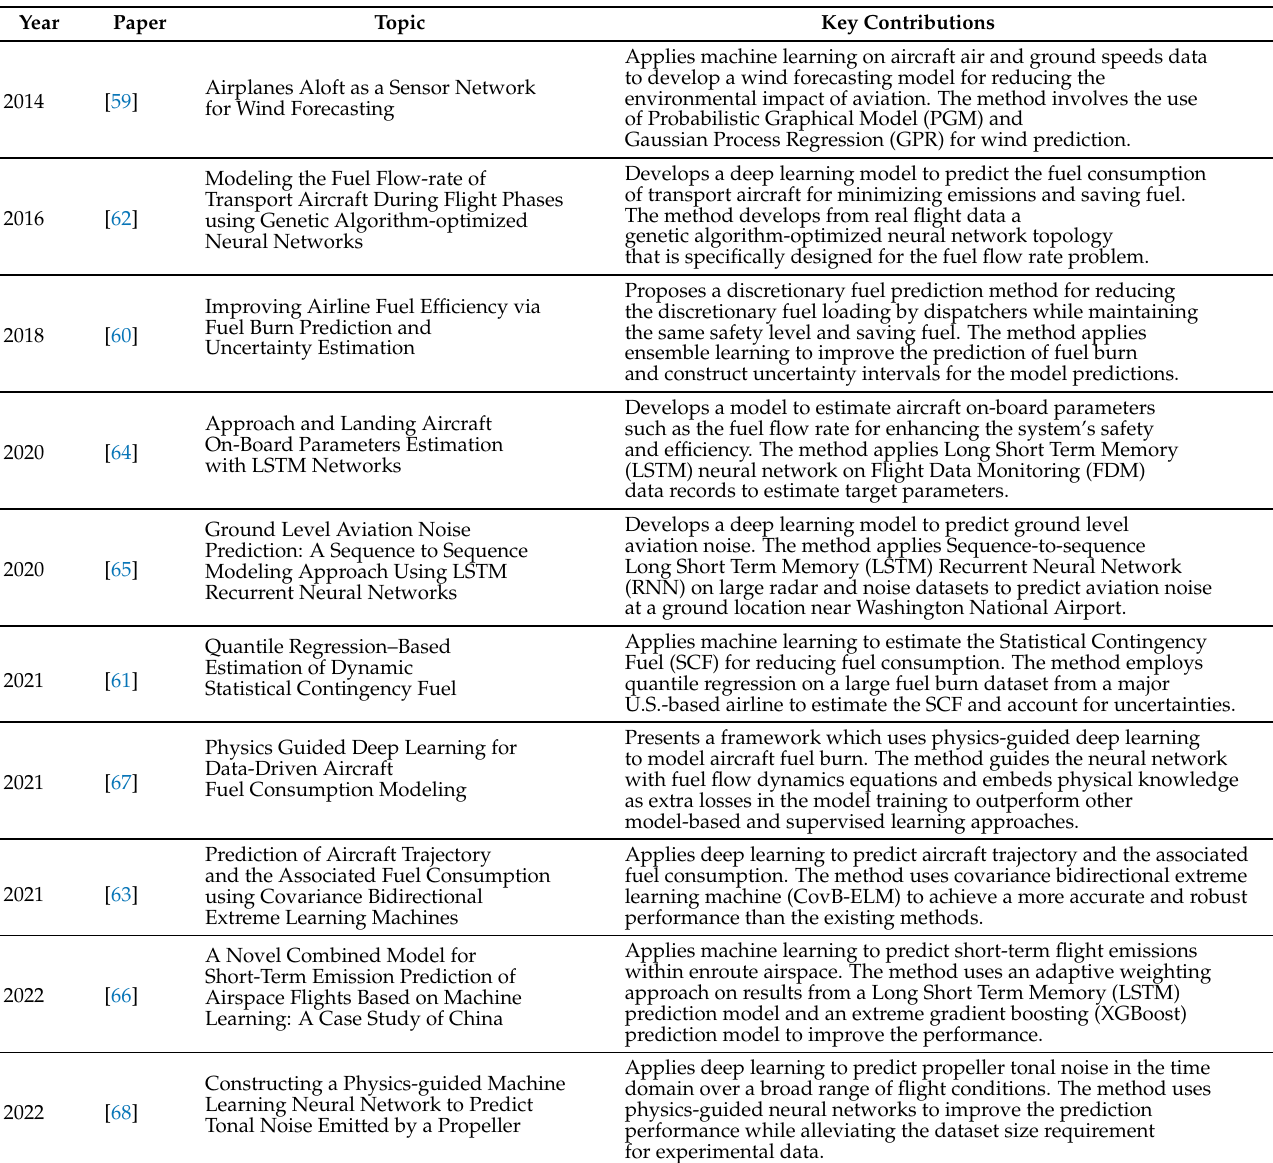
Table 4. Summary of representative papers in predictive